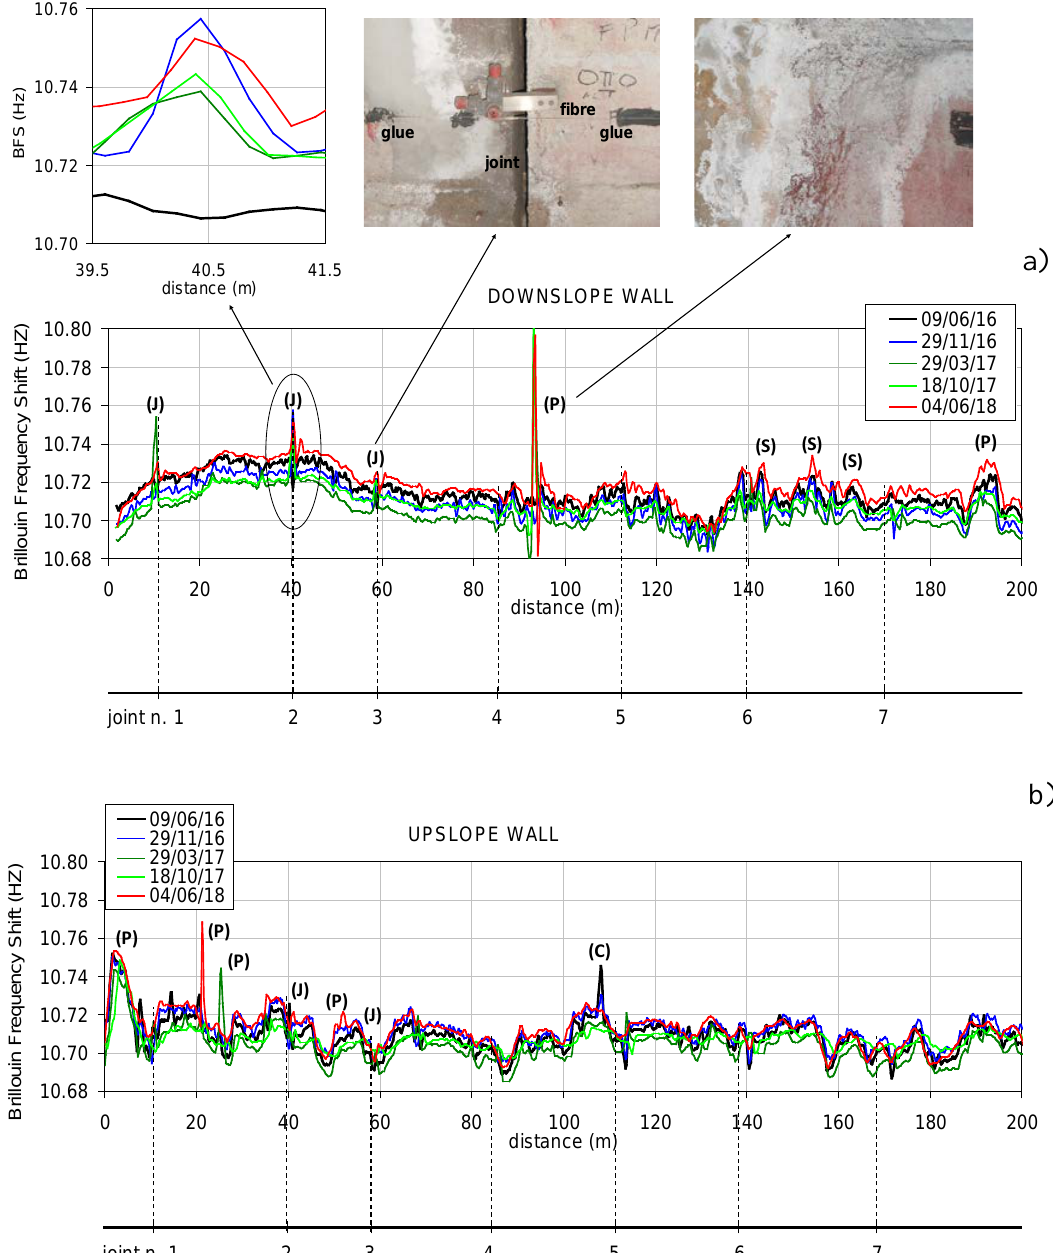
Figure 6. Results of optical fiber measurement along the downslope ( a ) and upslope ( b ) tunnel walls with localization of joints. Bracketed letters indicate: Joint opening (J); local deformations of the walls due to parget swelling (P) or to salt precipitate accumulation (S); crack (C).